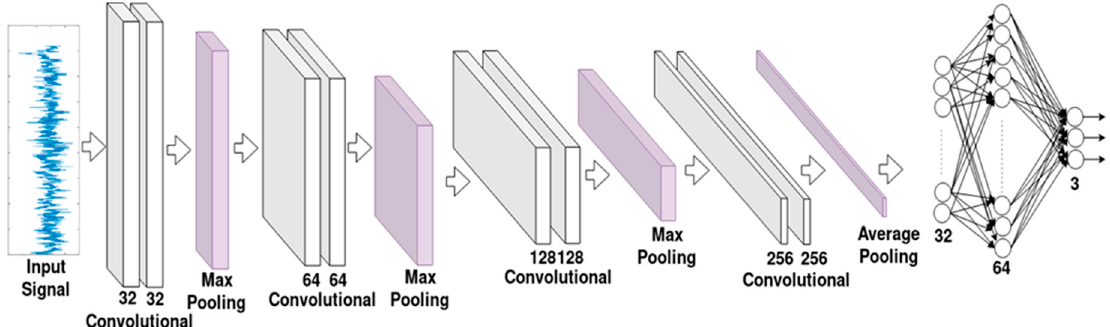
Figure 1. One-dimensional convolutional neural network (CNN).